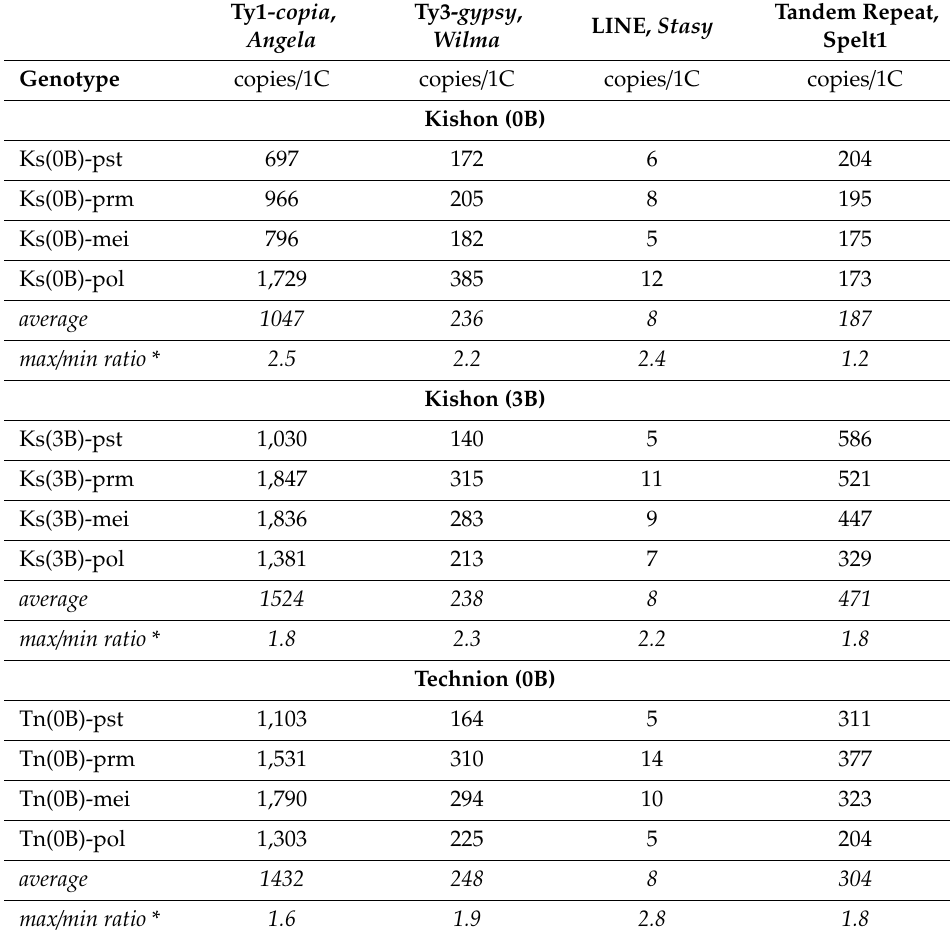
Table 2. Copy numbers in absolute quantification per haploid genome of Angela , Wilma , and Stasy retrotransposons and Spelt1 tandem repeat in spikes of Ae. speltoides individual genotypes. Tandem Repeat, Ty1 -copia , Ty3- gypsy , LINE, Stasy Angela Wilma Spelt1 copies / 1C copies /